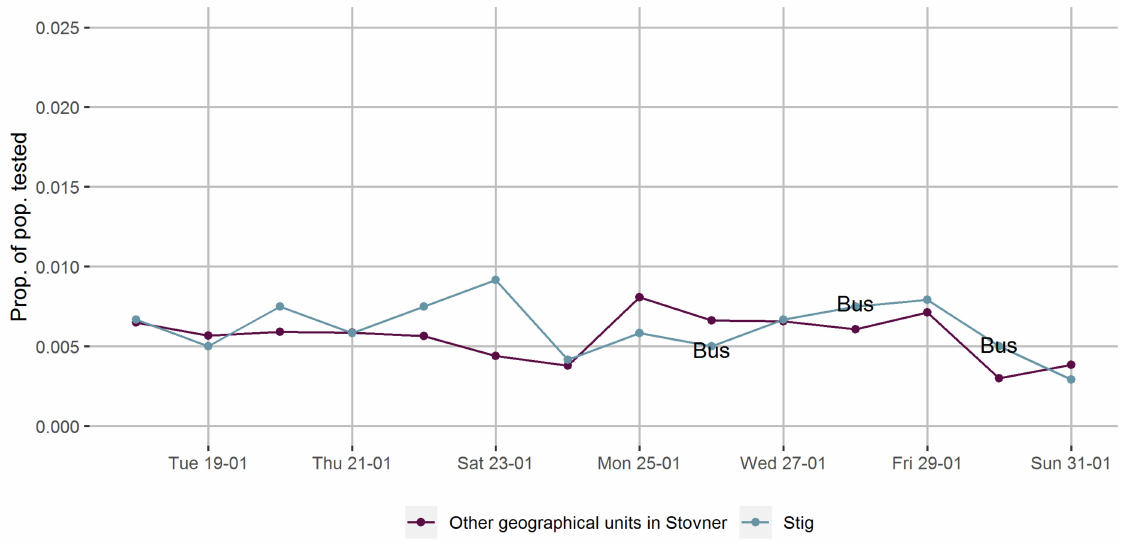
Figure 6. Proportions of the population tested for COVID-19 in geographical units with (purple) and without (blue) a mobile COVID-19 testing facility (bus).